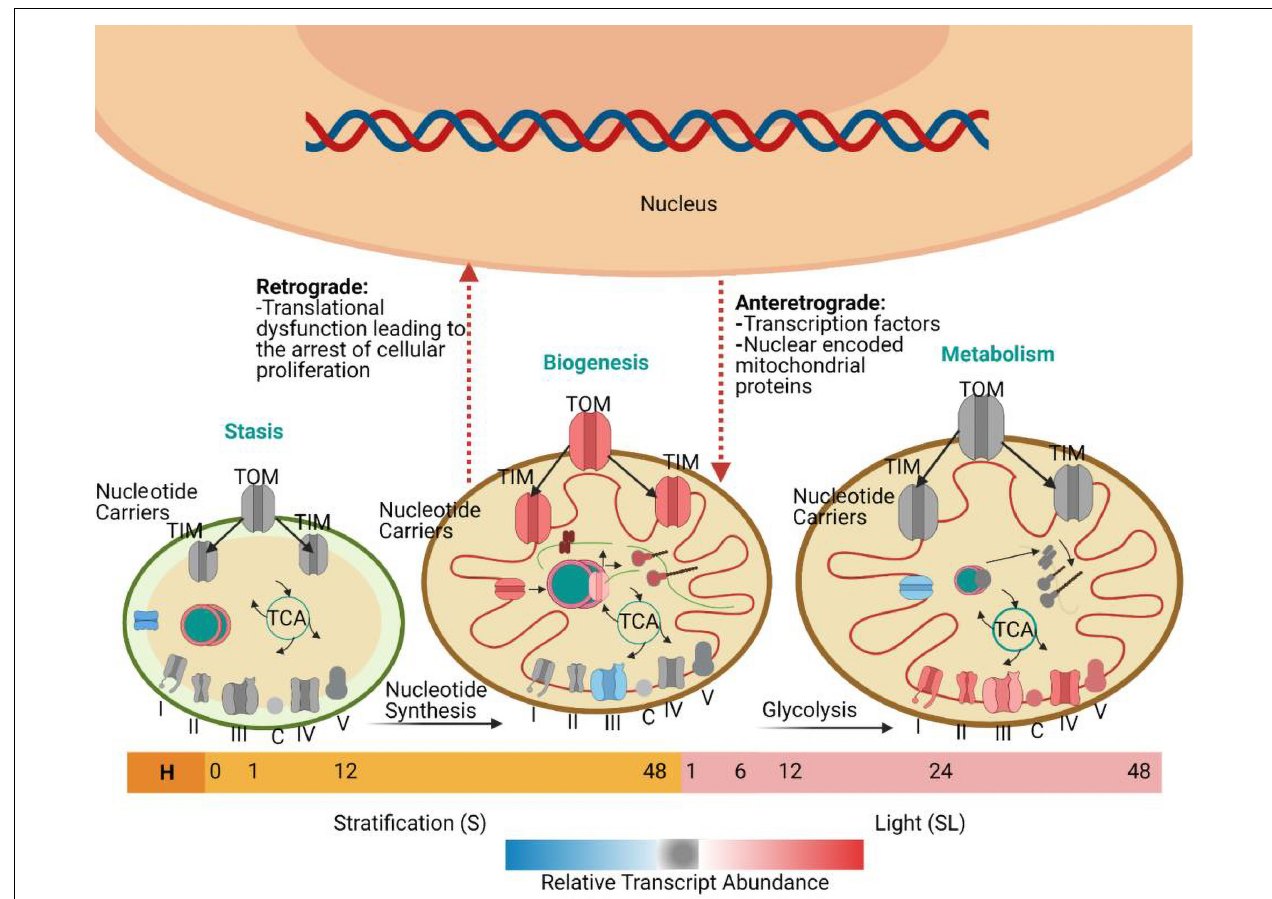
FIGURE 2 | Mitochondrial biogenesis during seed germination, based on the work of Law et al. (2012). Seeds were collected at ten time points: H (freshly harvested); 0 h (dry seeds after two weeks of desiccation); 1 h S, 12 h S, and 48 h S [three time points during seed stratification (S)]; and 1 h SL, 6 h SL, 12 h SL, 24 h SL, and 48 h SL [five time points during the exposure to continuous light after stratification (SL)]. The promitochondria in dry seeds do not have the cristae that are associated with mature mitochondria. The transient expression of transcripts encoding proteins associated with DNA and RNA metabolism and nucleotide synthesis and import occurs when the seed is shifted from stratification to continuous light. Afterward, there is transient expression of transcripts encoding proteins for protein metabolism and import functions. During the next stage, after 24 h of continuous light, there is increased expression of genes encoding various metabolic components associated with the Tricarboxylic acid (TCA) cycle and the electron transport chain. The progress of each minute event in this process is closely monitored by the nucleus and mitochondrion through processes known as antegrade and retrograde regulation. TIM, the inner membrane; TOM, the outer